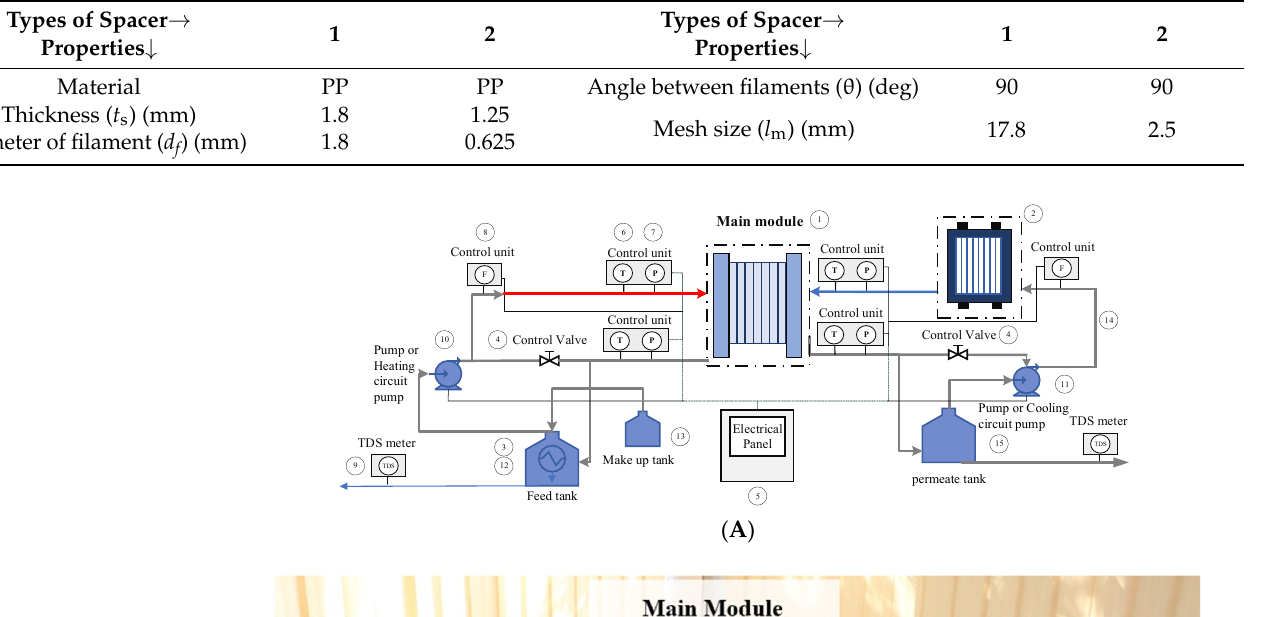
Figure 4. The proposed spacers: ( A ) spacer 1, ( B ) spacer 2. Table 3. The specification of the spacers used in this study.